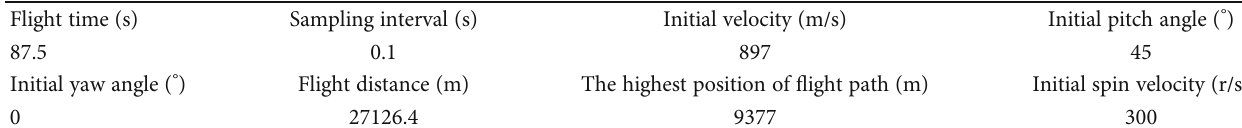
Table 1: Initial conditions of a simulation experiment.